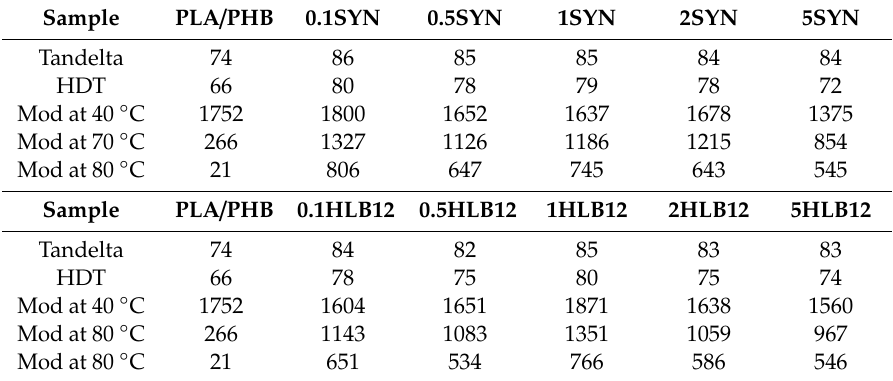
Figure 3. Thermomechanical measurement (DMA) traces for ( a ) Syn- and ( b ) HBL12-containing systems, compared to those of the PLA / PHB blend. Table 4. Mechanical properties of the neat blend, Syn-, and HLB12-containing